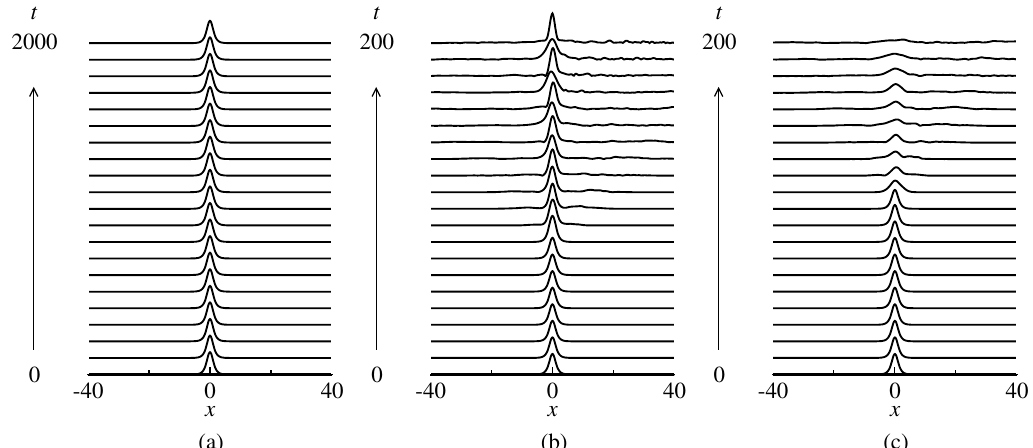
Figure 5. Propagation of Type 1 asymmetric an symmetric solitons with ω = 0.0, η = 0.15, λ = 0.1, and m = 0.1. ( a ) stable asymmetric soliton ( u 1 − component), ( b ) unstable symmetric soliton ( u 1 − component) and ( c ) unstable symmetric soliton ( u 2 − component).